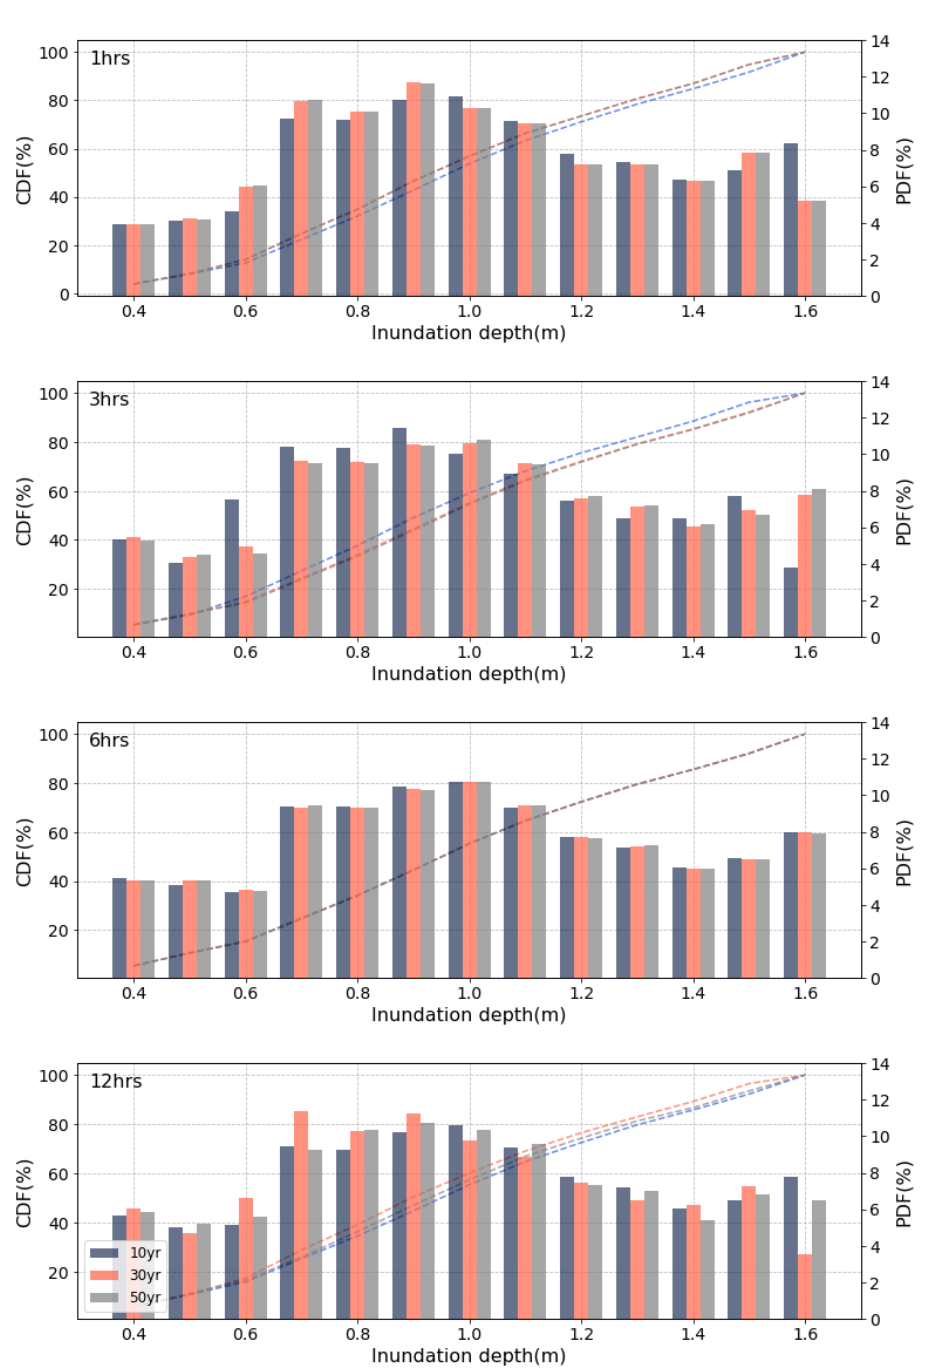
Figure 7. PDF and CDF of simulated inundation depth for target period II (2040 – 2070).